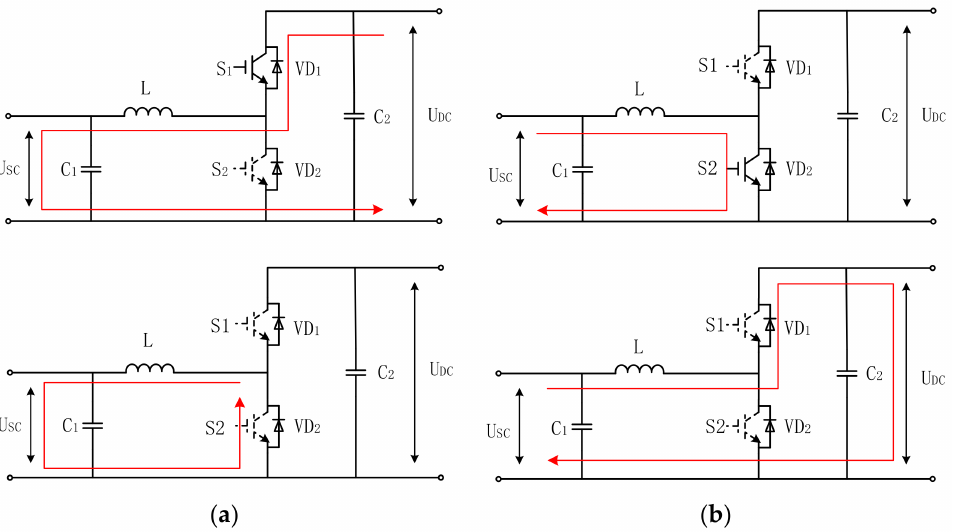
Figure 7. The bidirectional DC–DC working mode: ( a ) buck mode and ( b ) boost